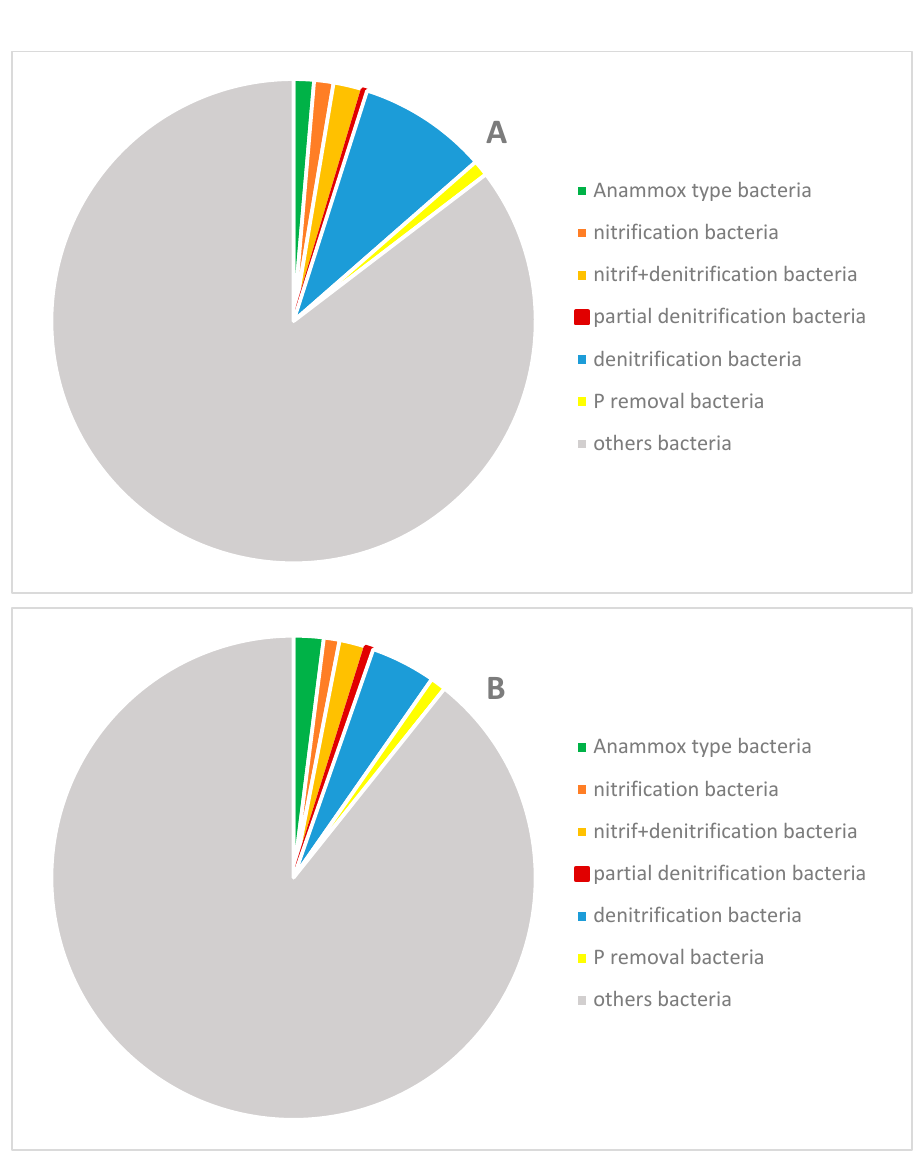
Figure 11. Bacterial community structure shown as the percentage share of anammox bacteria, nitrifiers, denitrifiers, and P-removing bacteria in the two types of PUR foam samples (( A ) and ( B ) refer to the PUR foam samples ( A ) and ( B ), respectively).